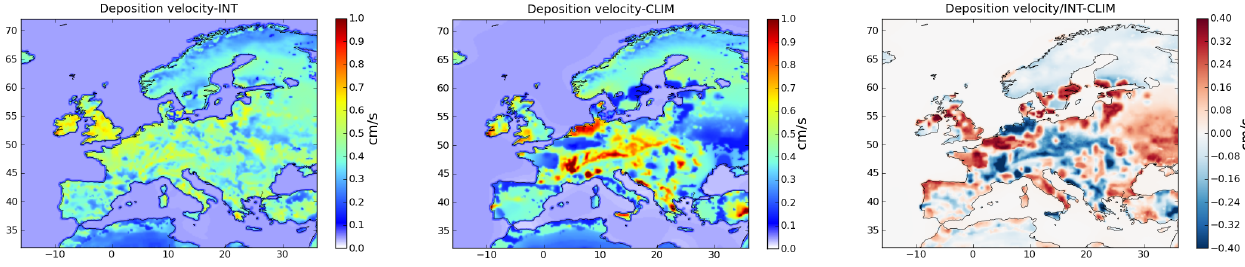
Fig. 7. O 3 deposition velocity averaged for the summertime period simulated by INT (left) and CLIM (middle). Differences between INT and CLIM are shown on the right.